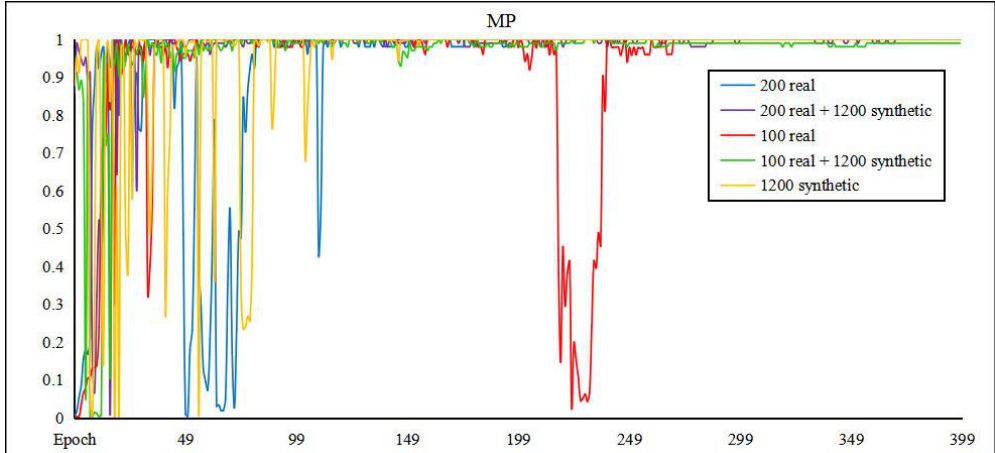
Figure 18. The mean precision for different datasets.